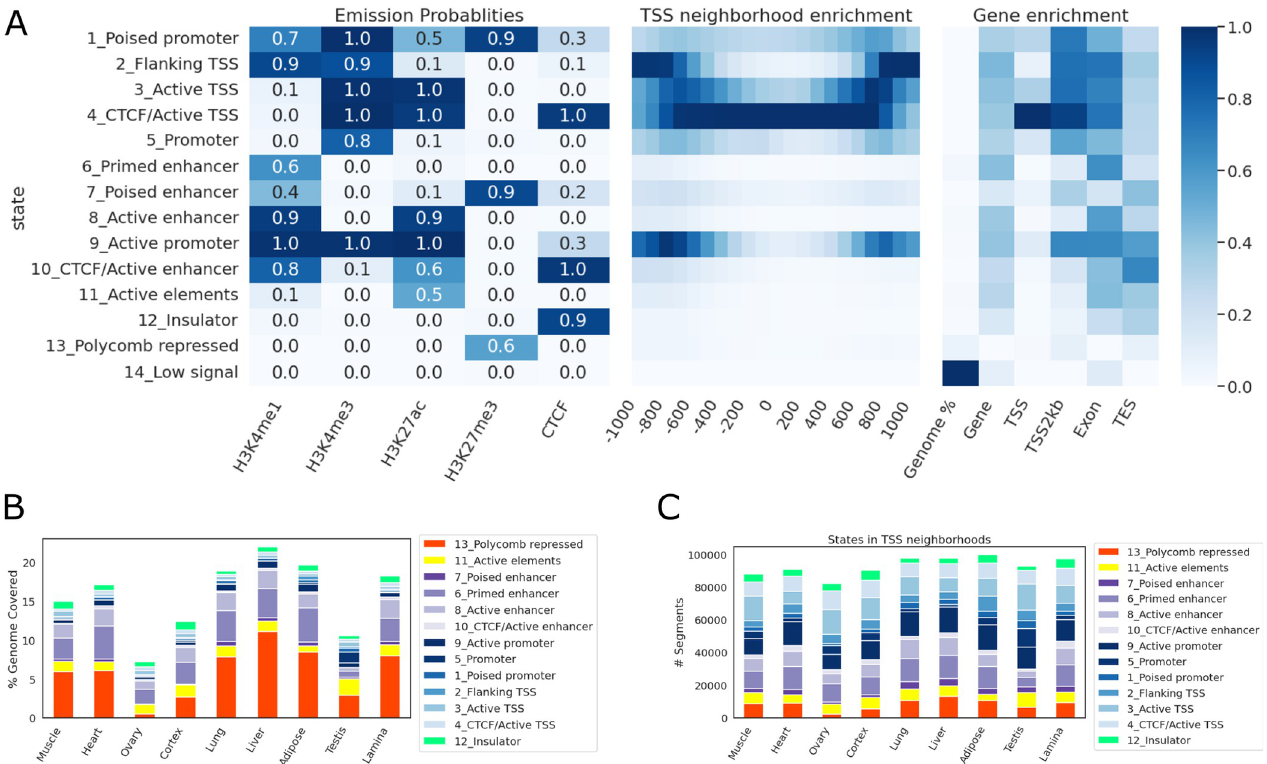
Fig 6. Chromatin states. (A) Emission probabilities, TSS neighborhood enrichment, and different genic features’ enrichment at each state. (B) The percentage of genome covered by each state in each tissue. (C) The number of segments from each state in each tissue.